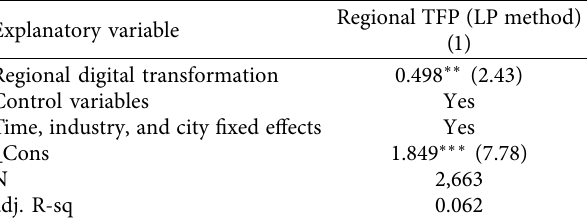
Table 3: Robustness